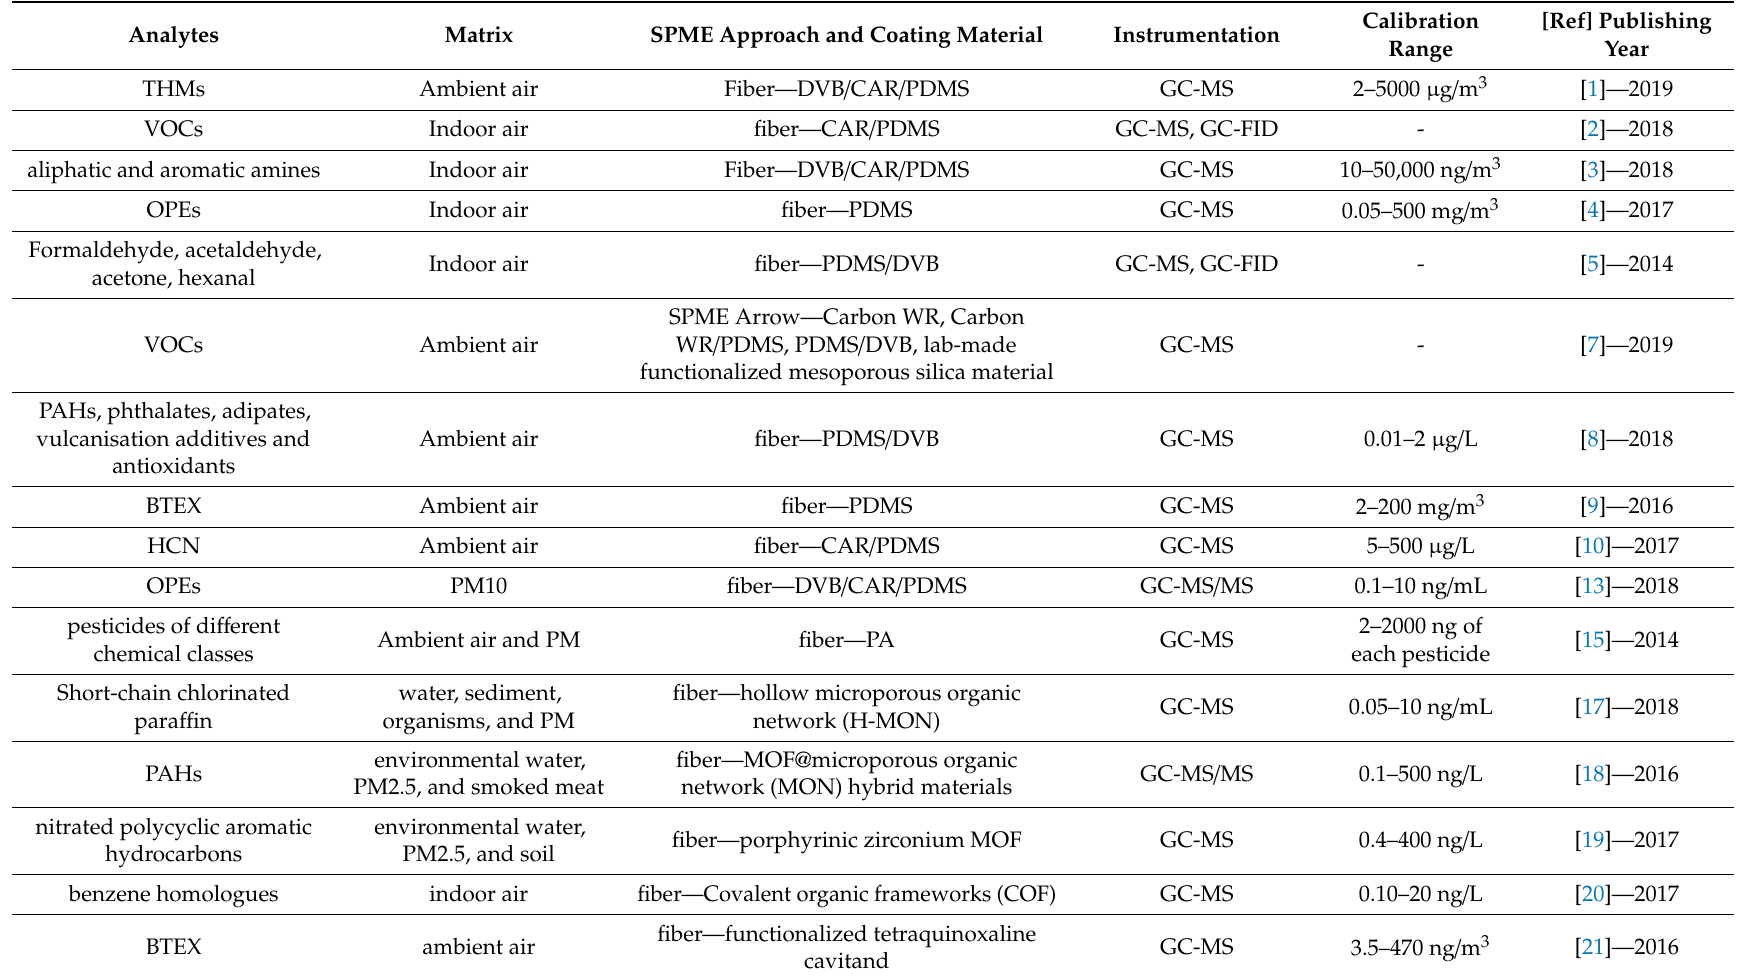
Table 1. Selected SPME applications in environmental